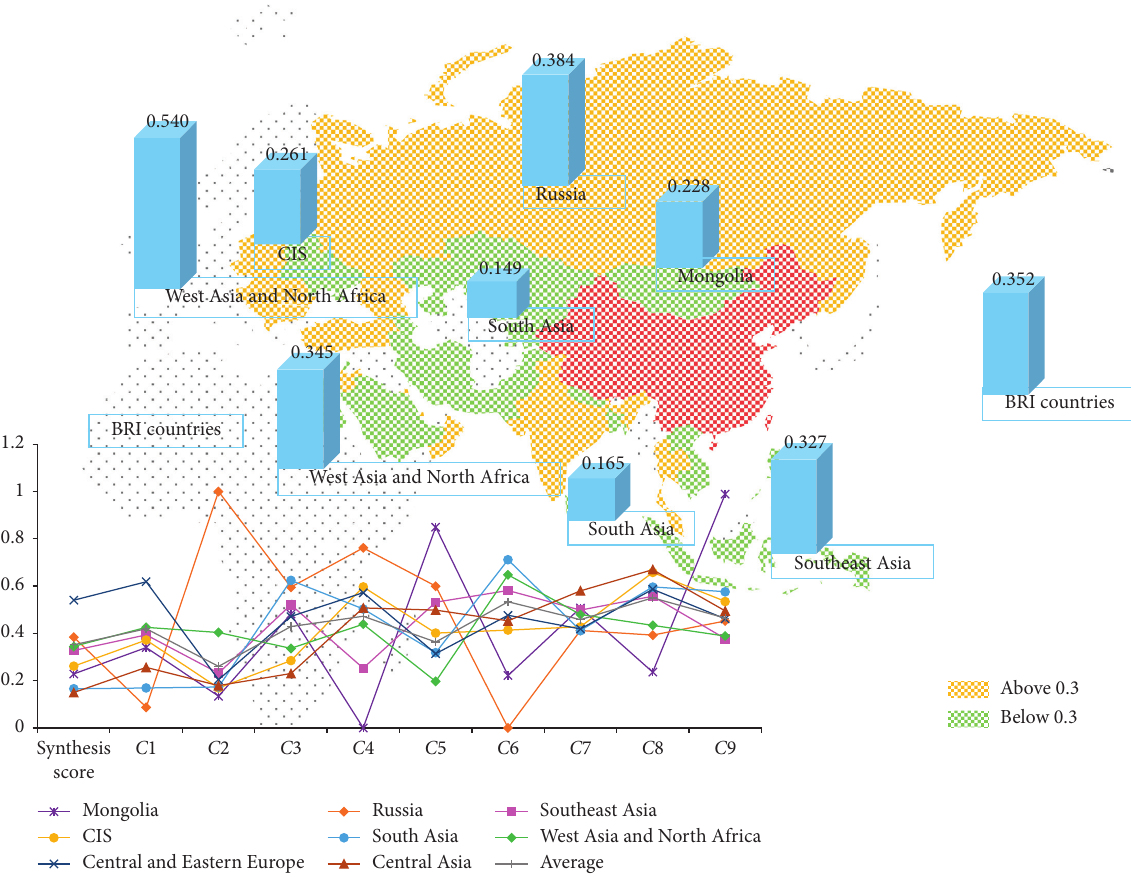
Figure 3: Regional assessment results of